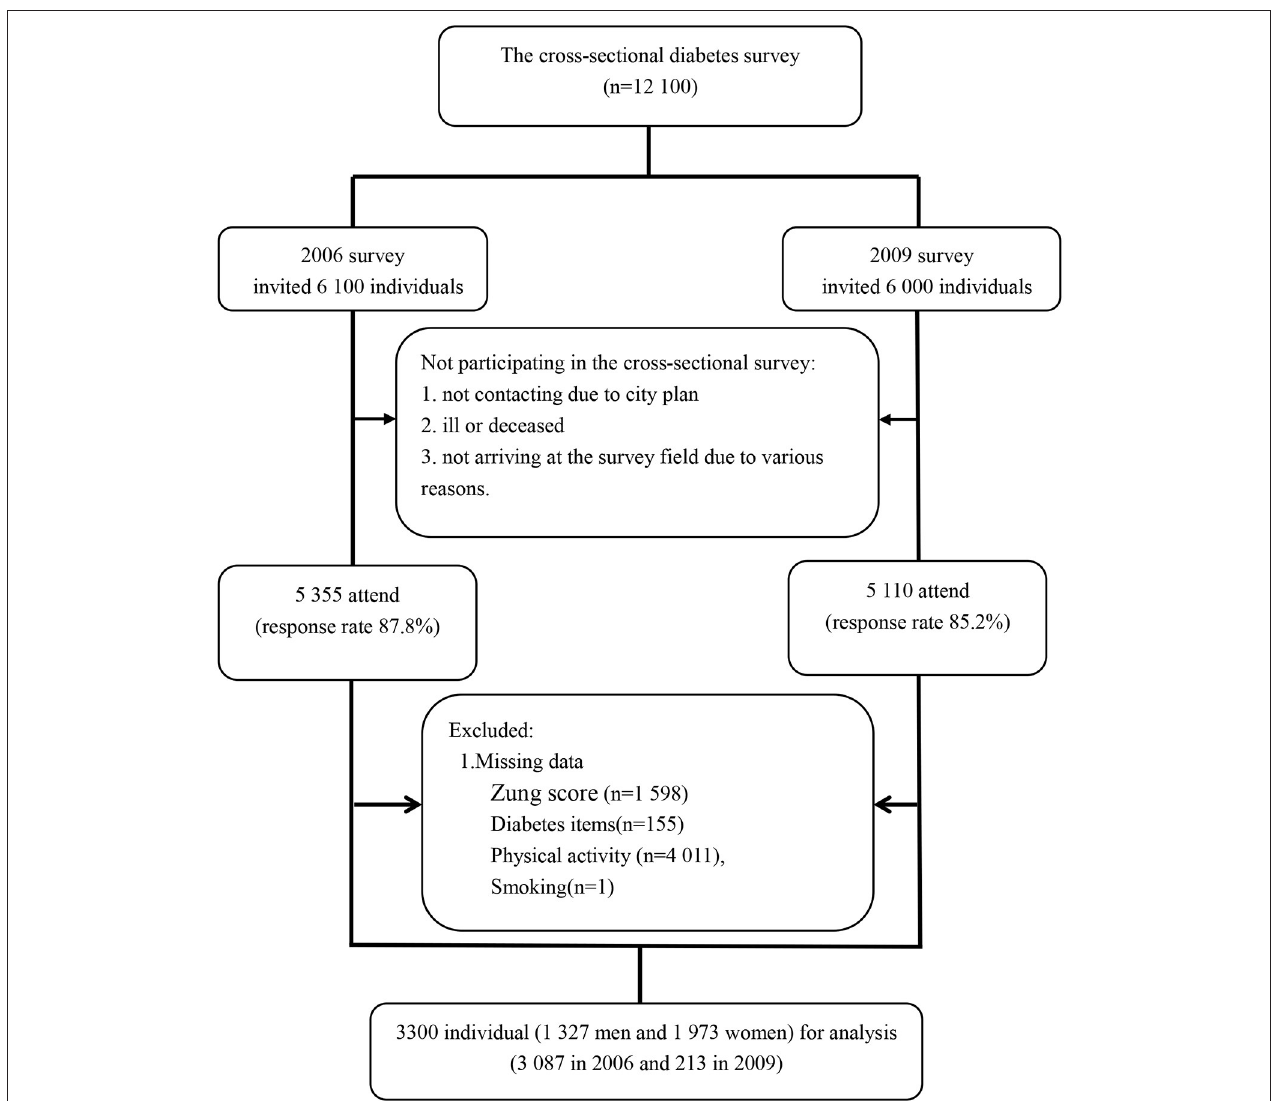
FIGURE 1 | Flow chart of participants included in the cross-sectional